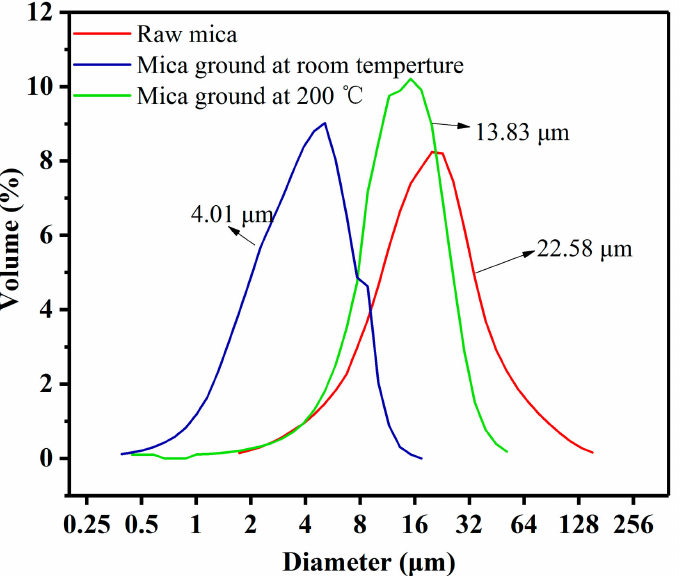
Figure 1. The particle size distribution and average particle size of raw mica, mica ground at room temperature, and mica ground at 200 ◦ C.